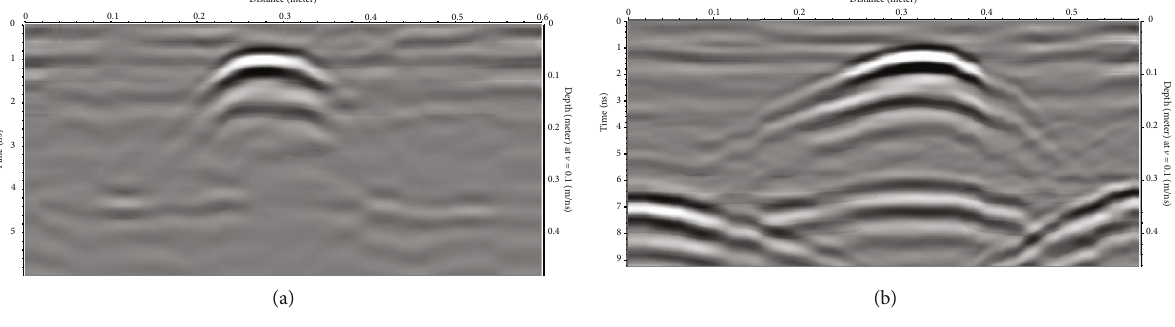
Figure 4: Single metal pipe (a) and two metal pipes Table 2: Coordinates of control points of spline curves.